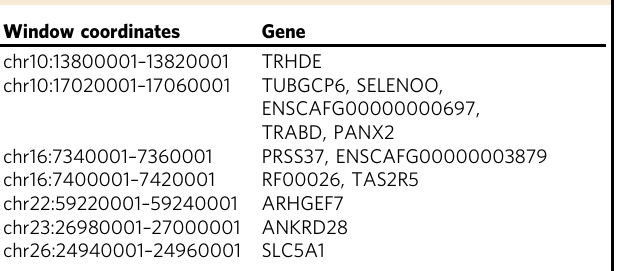
Table 1 The 13 genes under selection in both domestication and